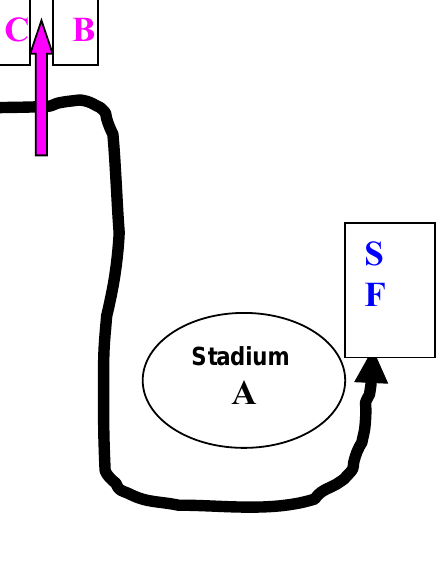
Fig.1. Diagram of distance for militarized